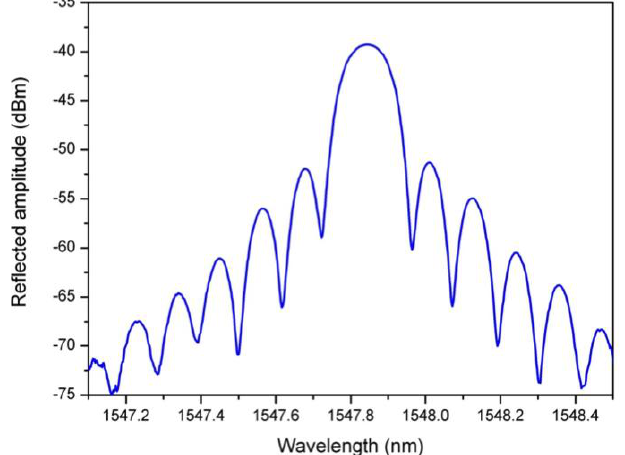
Figure 1. Reflected amplitude spectrum of a 1 cm long uniform